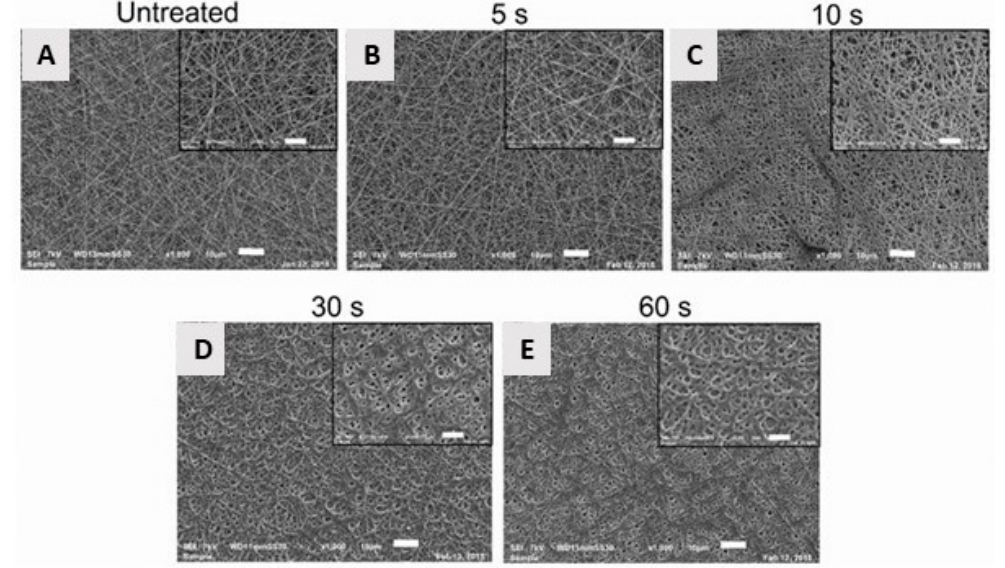
Figure 25. SEM images of PCL nanofibers before ( A ) and after 1-propanethiol plasma polymerization with a plasma exposure time of 5 s ( B ), 10 s ( C ), 30 s ( D ) and 60 s ( E ) (scale bars = 5 and 10 µm)—reproduced with permission from [301]. Copyright Elsevier, 2019.